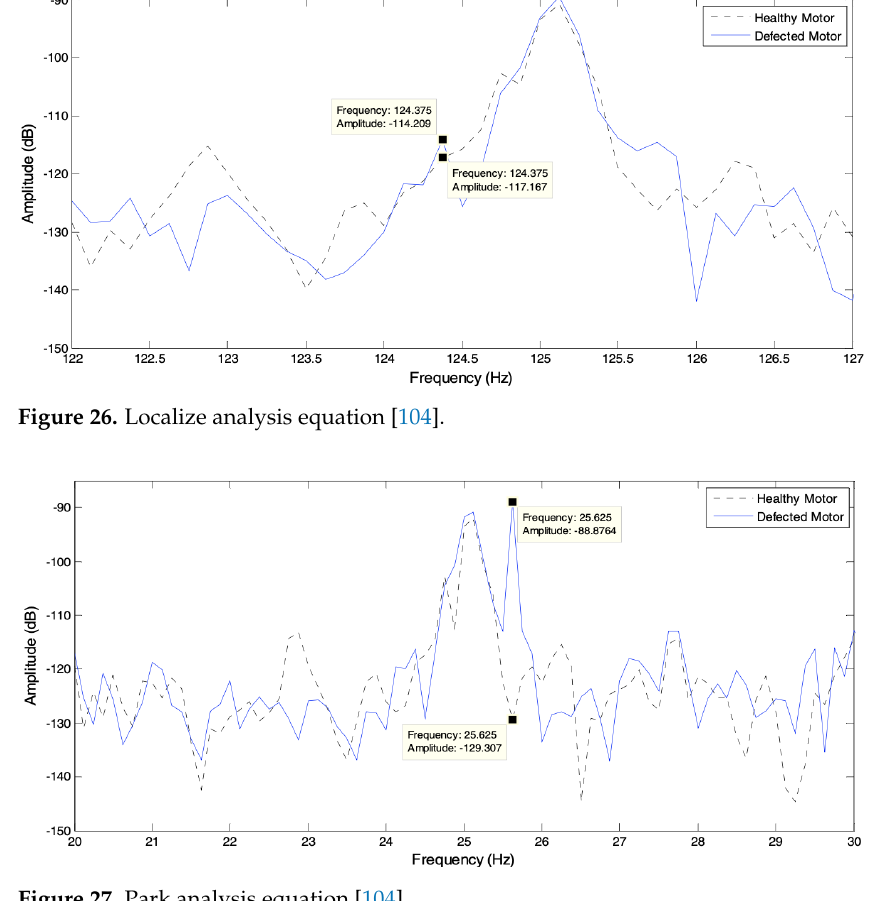
Figure 27. Park analysis equation